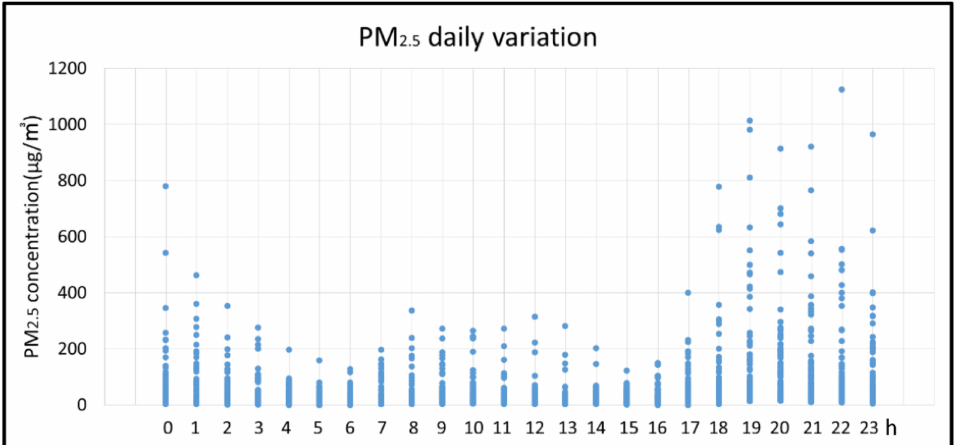
Figure 4. Daily variation in PM 2.5 concentration from April 2019 to August